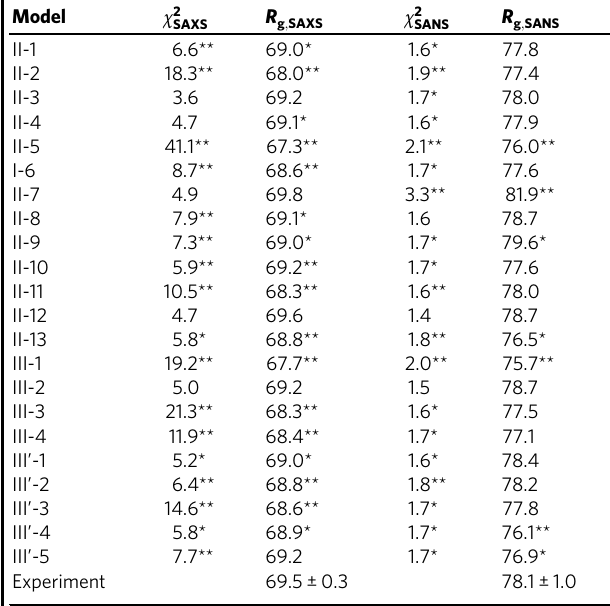
Table 1 Time averaged χ 2 100 ns MD simulated